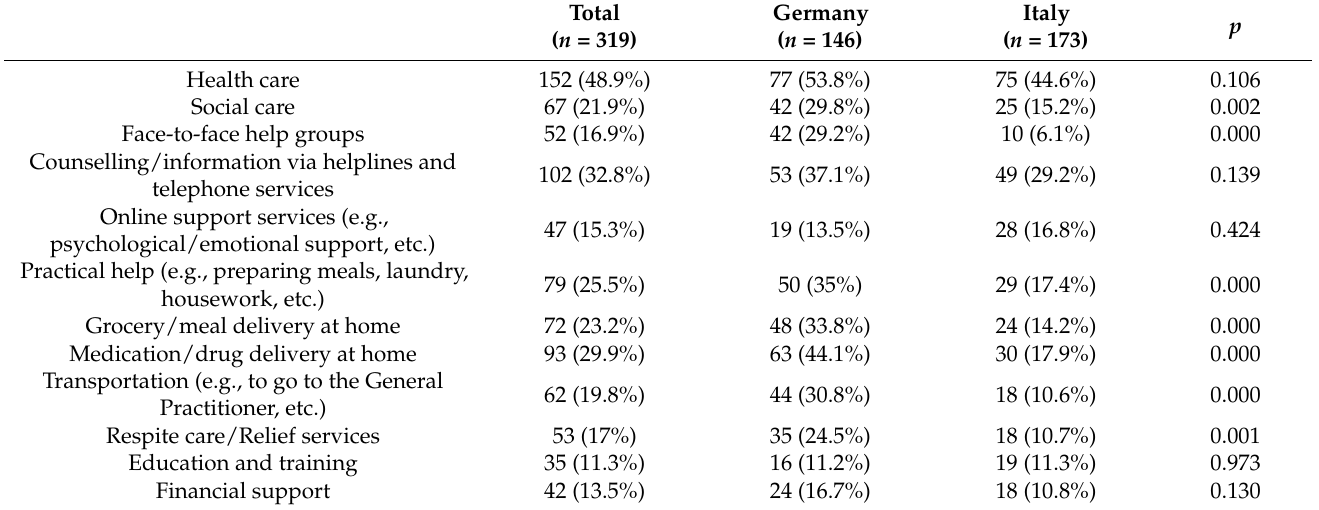
Table 2. Formal supports received during the COVID-19